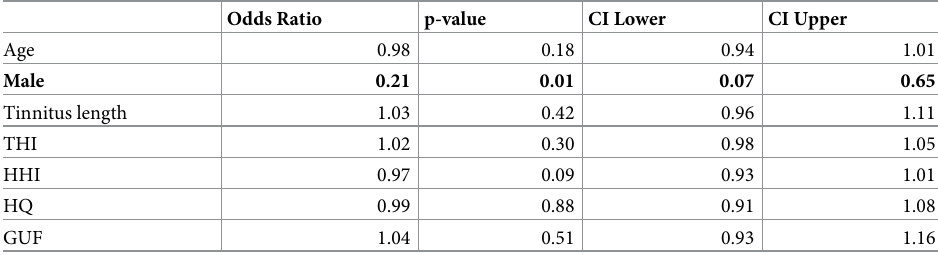
Logistic regression analysis for demographic characteristics, tinnitus length and questionnaire variables associated with a positive diagnosis of temporomandibular joint disorder. Significant results are shown in